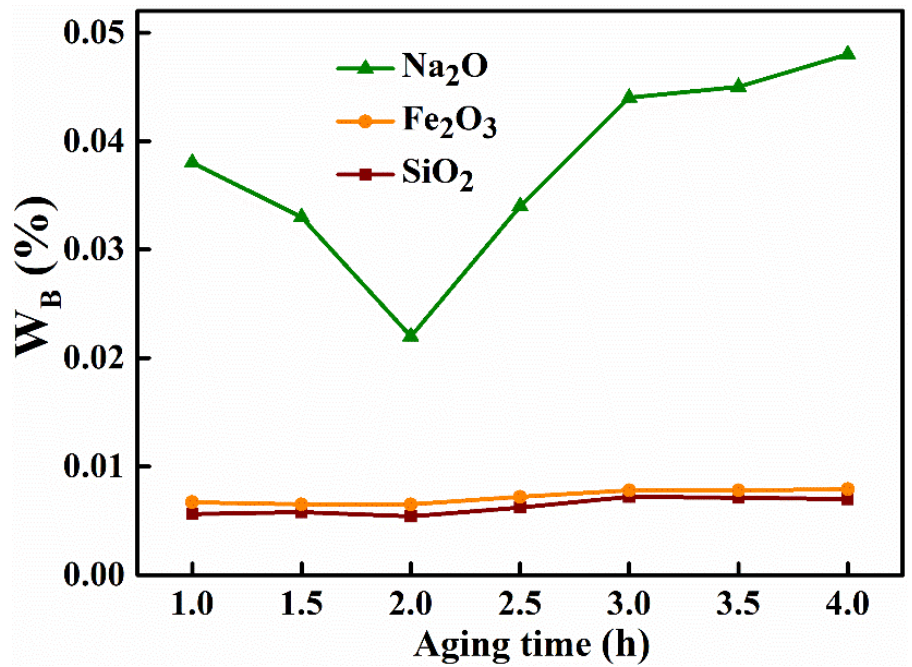
Figure 3. Effect of aging time on the impurity mass fraction in the product alumina. Table 5. Effect of aging time on impurity removal efficiency and alumina purity. Aging